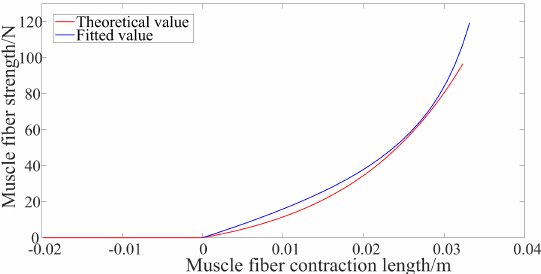
Figure 3. Passive contraction force of skeletal muscle (Long head of biceps brachii) and its fitting. Muscle fiber contraction length = 0 means that the muscle is at rest (that is, the elbow flexion is about 60